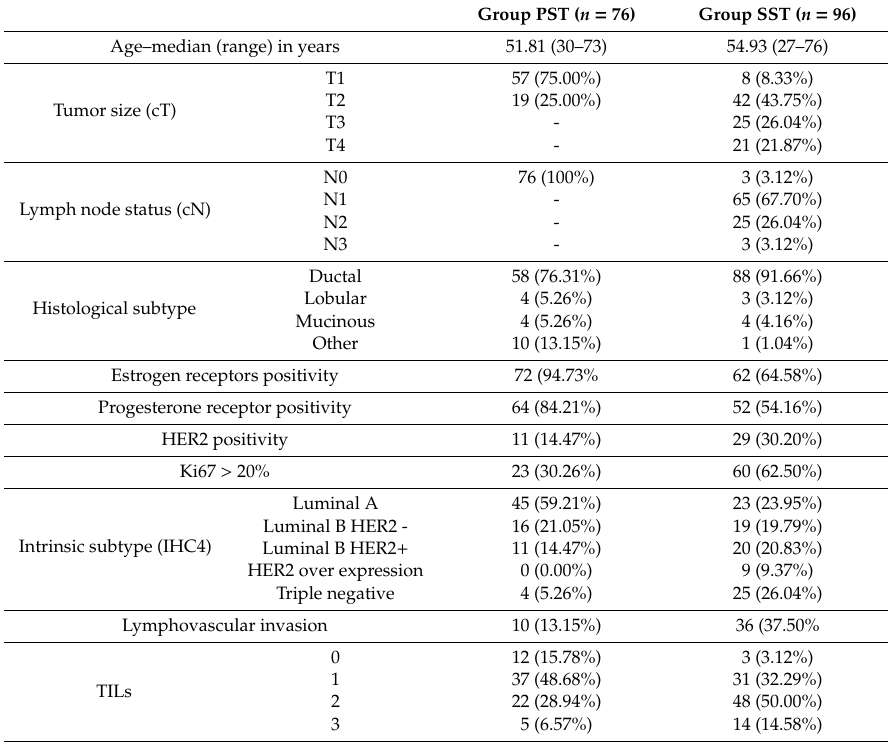
Table 1. Patients characteristics in the two